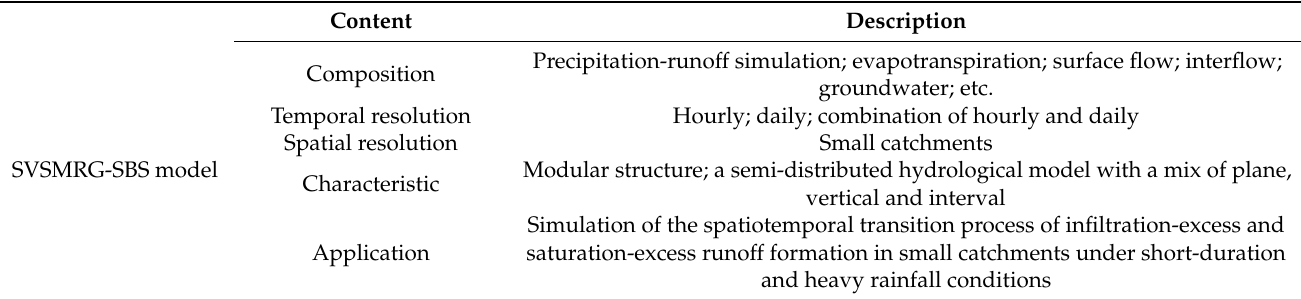
Table 3. Summary of SVSMRG-SBS model